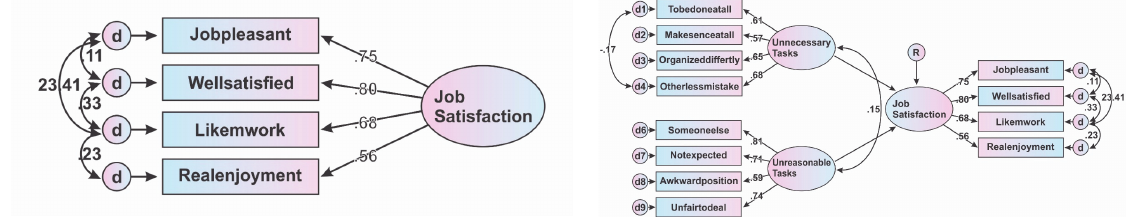
Fig. 4. Measurement model of job satisfaction Fig. 5. Revised Structural Equation